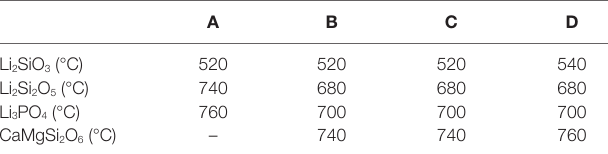
TaBle 3 | sequence of crystal phase formation as a function of temperature determined by hT-XrD. a B c